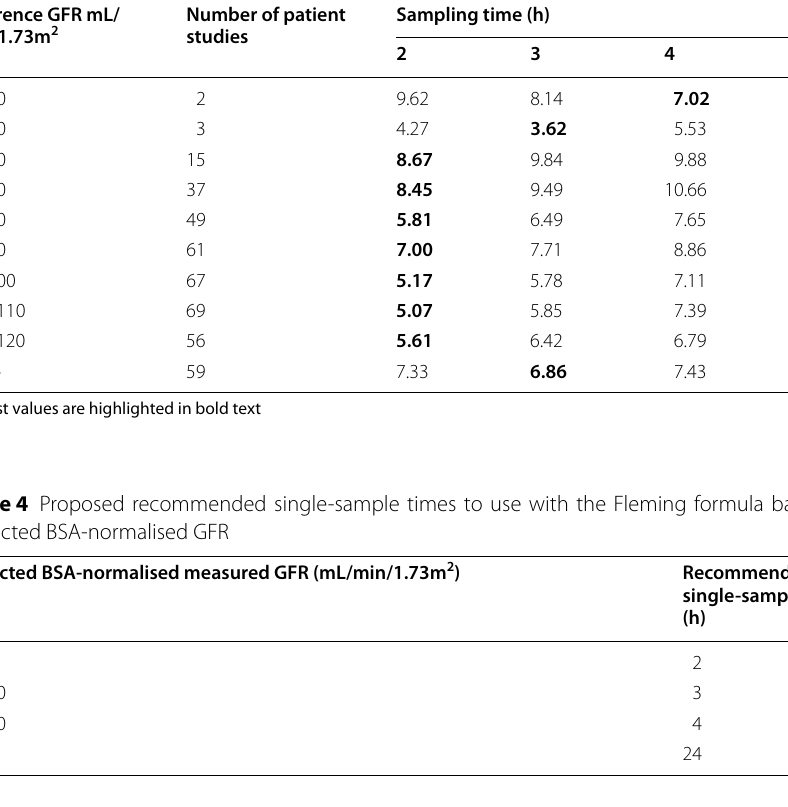
Table 3 Root mean square (rms) error in units of ml/min/1.73m 2 between single-sample GFR and reference GFR measurements Reference GFR mL/ Number of patient min/1.73m 2 studies